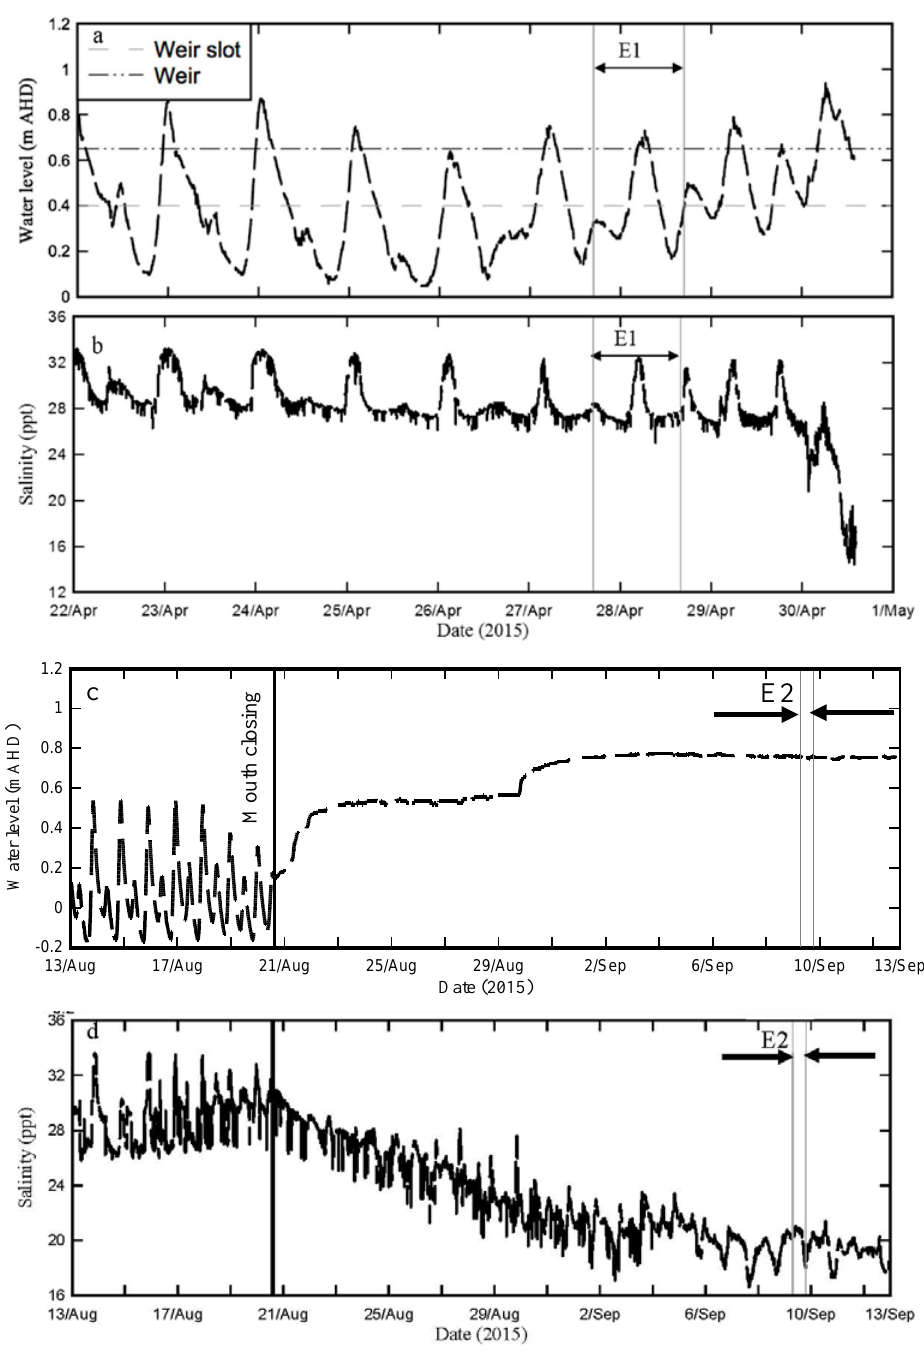
Figure 2. Time series of: ( a ) Water level around E1, ( b ) Salinity around E1, ( c ) Water level around E2 ( d ) Salinity around E2; Measured at the bridge location marked X (Figure 1).